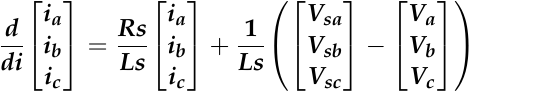
    ,  and  represents per phase grid voltage while V sa , V sb and V sc represents per phase grid voltage while V a , V b and V c represents per sents per phase D.G. output voltages. By using Park’s Transformation Equation (1) can be phase D.G. output voltages. By using Park’s Transformation Equation (1) can be written in written in dq reference frame as, dq reference frame as,